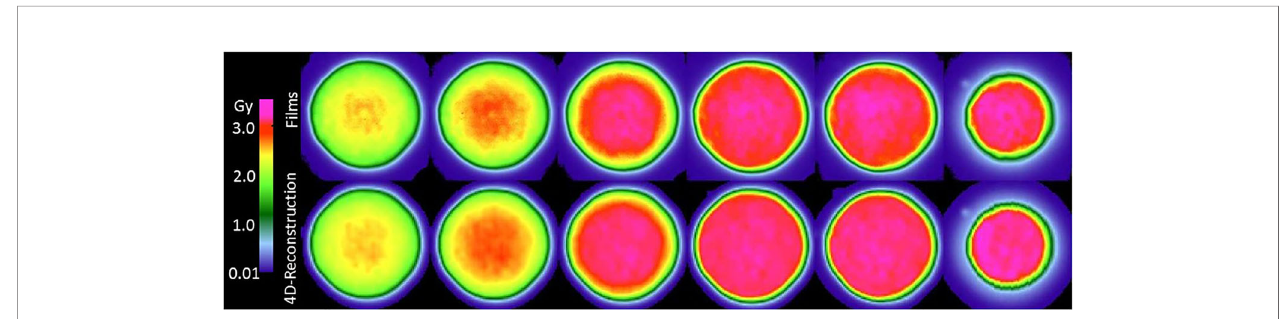
FIGURE 2 | Comparison of fi lm measurements (top row) to dose reconstructions (middle row). The top row shows the fi lms from a fi lm stack for a multi-phase 4D delivery using 10 motion phases to the wedge phantom with 20 mm uniaxial motion. Films are ordered left to right with increasing depth in the wedge phantom. The depth increment between fi lms is approximately 11 mm water-equivalent thickness. The corresponding dose reconstructions for the same delivery are shown in the middle